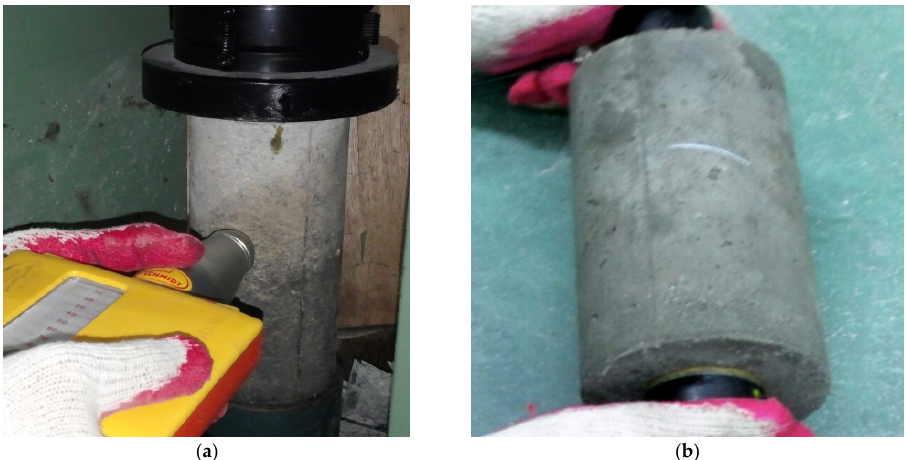
Figure 1. Non ‐ destructive test for the concrete cylinder specimen. ( a ) Rebound hammer test; ( b ) Direct ultrasonic pulse velocity